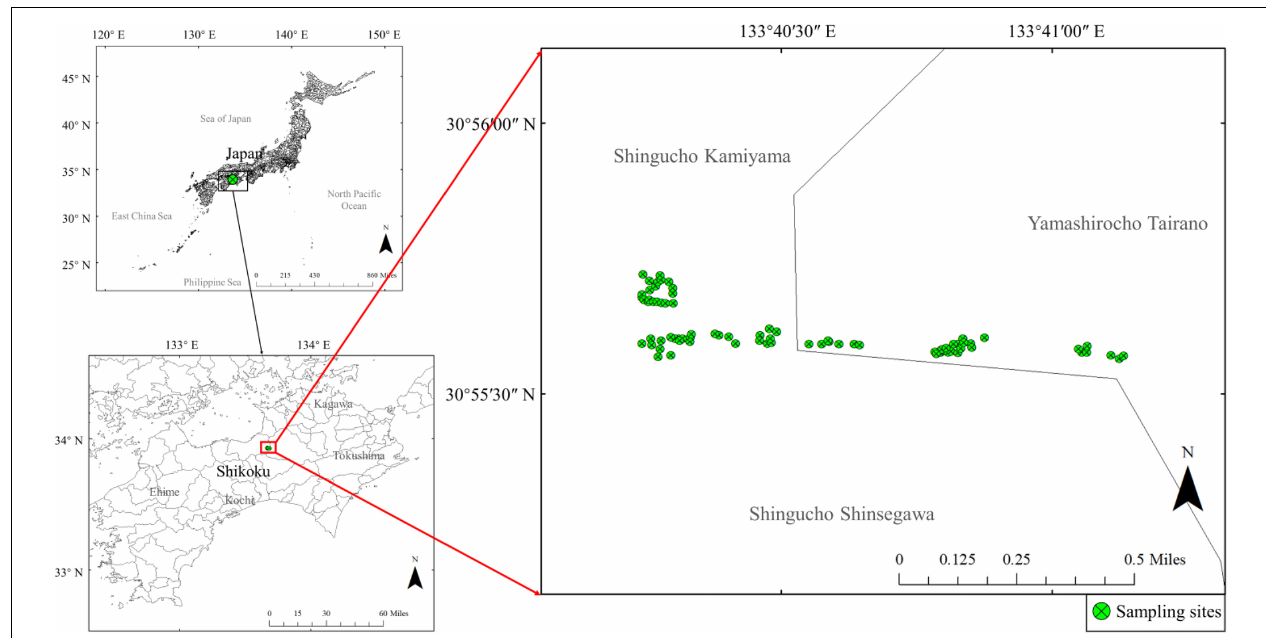
FIGURE 1 | Study area and sampling site. The top-left map shows the location of Shikoku in Japan and the bottom-left indicates the location of Shiozuka highland. The main map on the right shows the distribution of sampling sites in the Shiozuka highland.